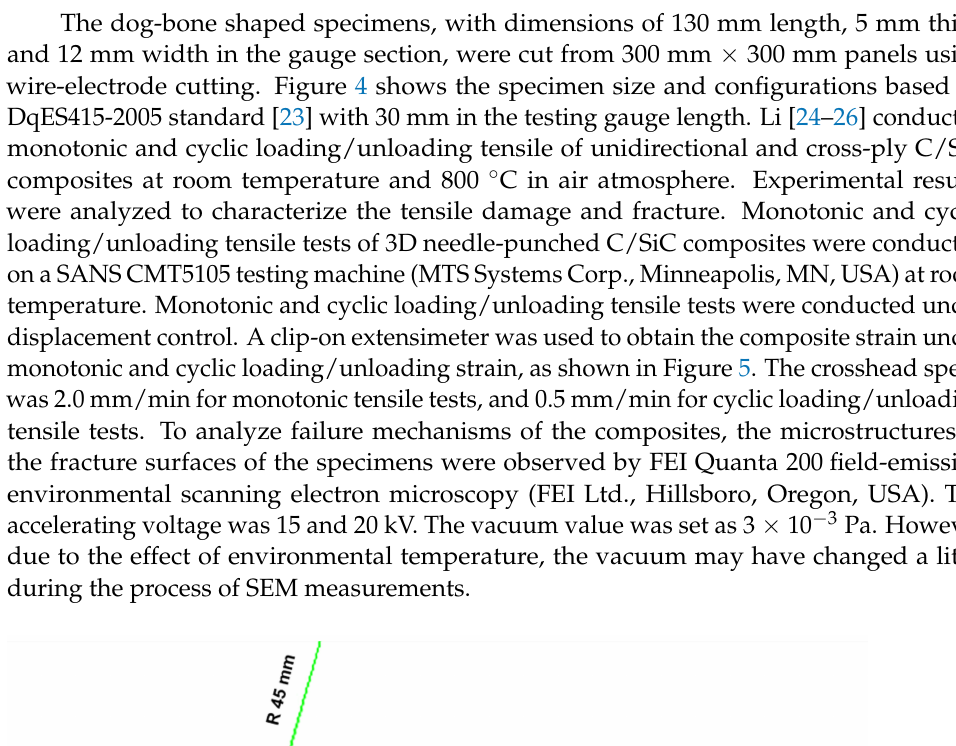
Figure 3. Macroscopic morphology of C/SiC composite after reactive infiltration.